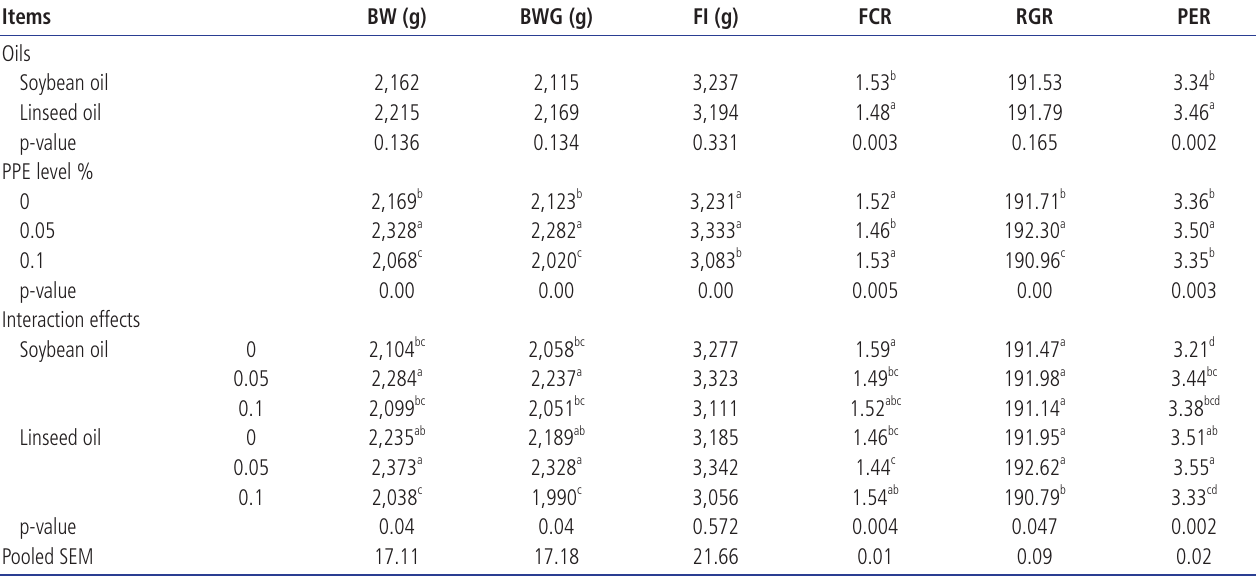
Table 5. Effects of different dietary levels of pomegranate peel extract with different oil sources and their interactions on broiler overall growth performance Items